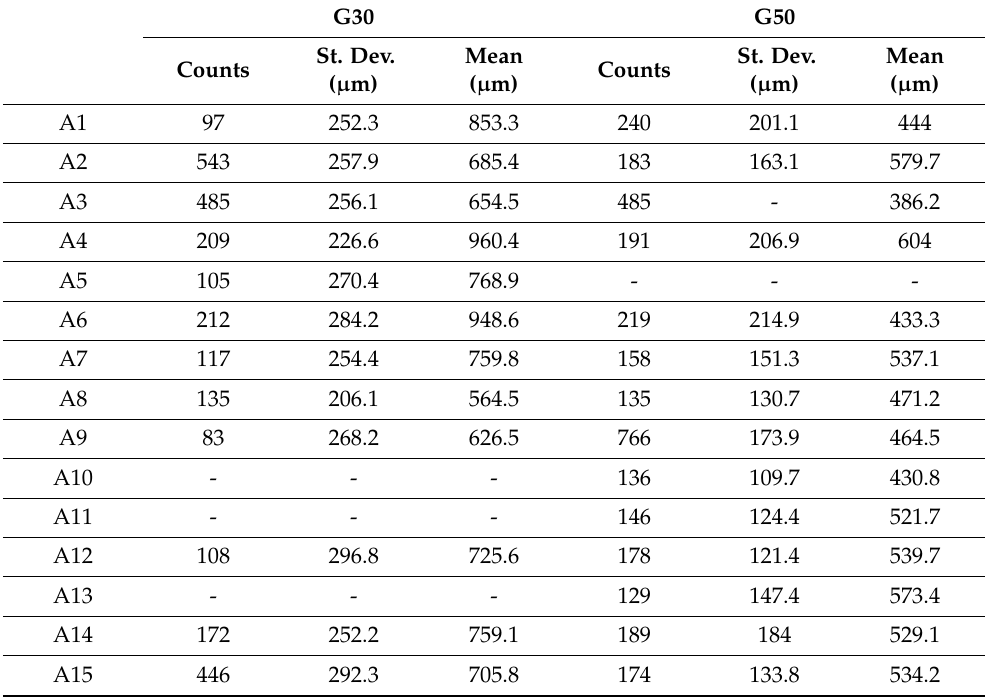
Table A5. Mean Window’s Feret diameter ( d w ) of CFF samples of Grade 30 and Grade 50 from supplier